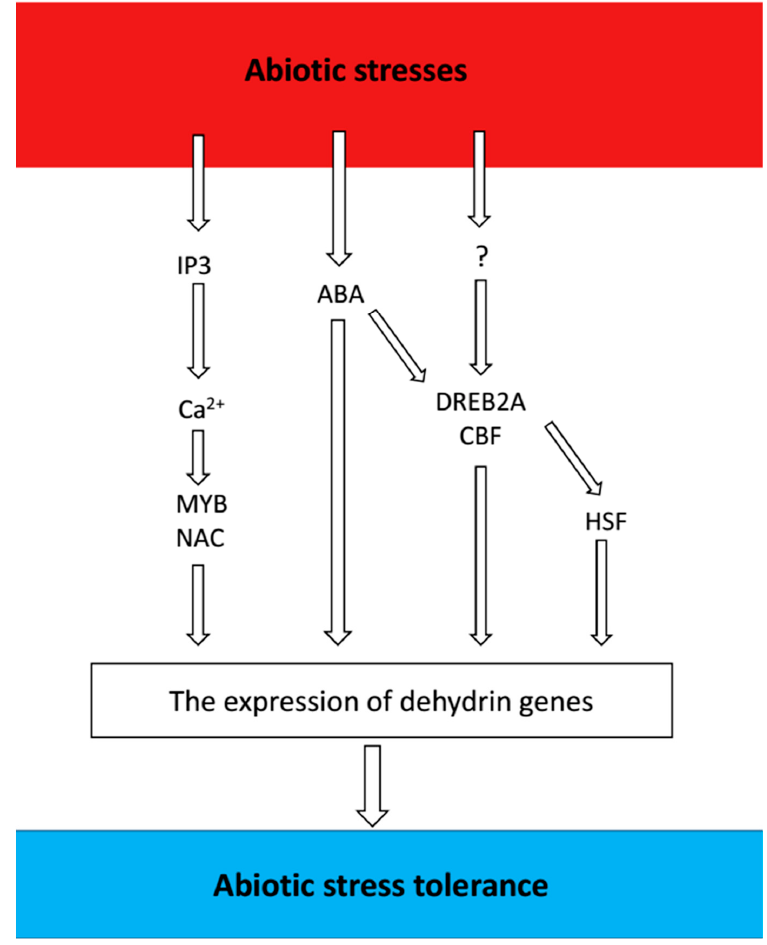
Figure 2. Overview of signaling pathways and factors involved in signaling regulation of dehydrin genes. The figure shows the signaling components involved in the abiotic stress responses that are described in the text. Question marks represent as-yet-unidentified factors in the corresponding signal transduction pathways.